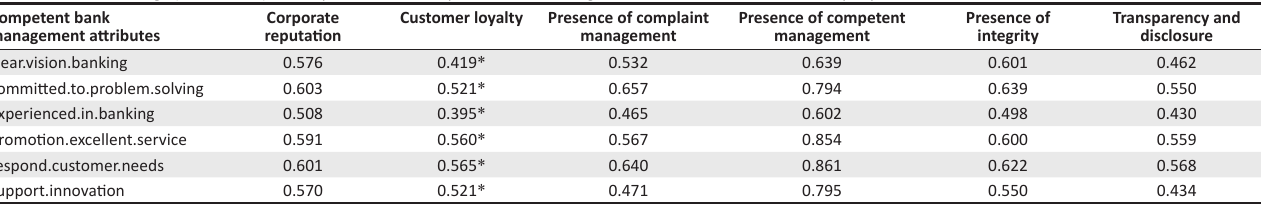
TABLE 4: Cross-loadings (correlation) of the presence of competent bank management attributes on customer loyalty.